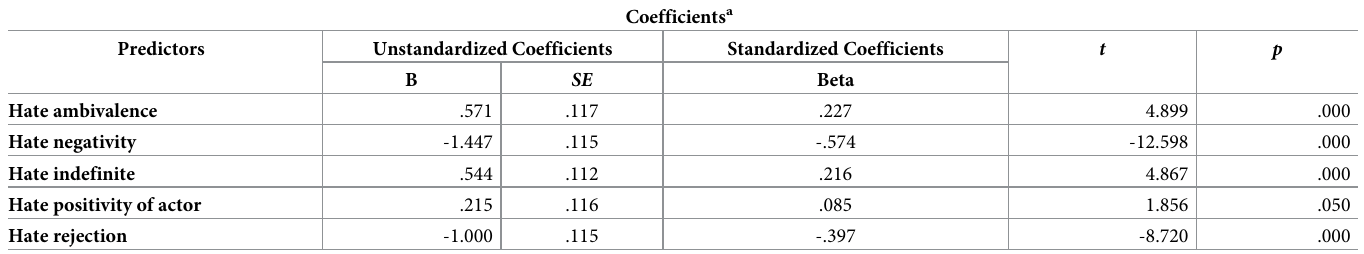
Table 8. Hate script: Multiple regression analysis; script’ factors predict